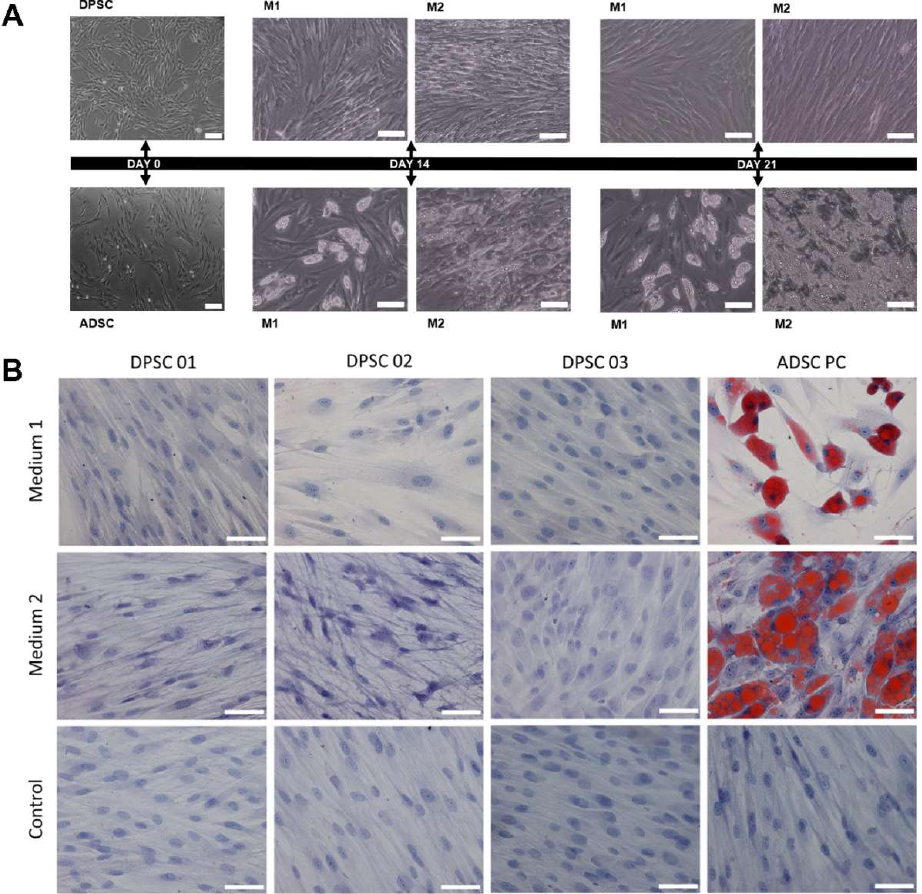
Figure 2. Adipogenic di ff erentiation of MSCs. ( A ) Morphological analysis of the cells on days 0, 14 and 21 after induction for adipogenic di ff erentiation in a representative sample. On days 14 and 21, the presence of lipid vacuoles is observed only in the ADSCs (positive control). Scale bar: Day 0: 20 µ m, Days 14 and 21: 100 µ m. ( B ) In vitro adipogenic di ff erentiation: comparison between the positive control (PC) (ADSCs) and three samples of DPSCs. Staining: Oil Red O. Scale bar: 50 µ m. MSCs: mesenchymal stromal cells ; ADSCs: adipose tissue-derived stromal cells, DPSCs: dental pulp-derived stromal cells. M1: medium 1, commercial culture medium, M2: medium 2, custom culture medium.